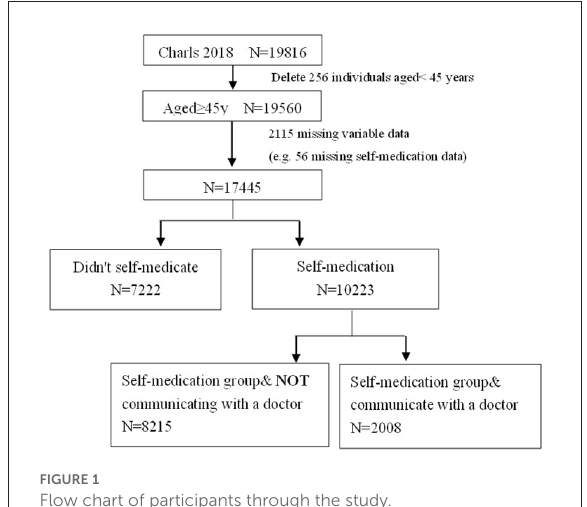
FIGURE1 Flow chart of participants through the